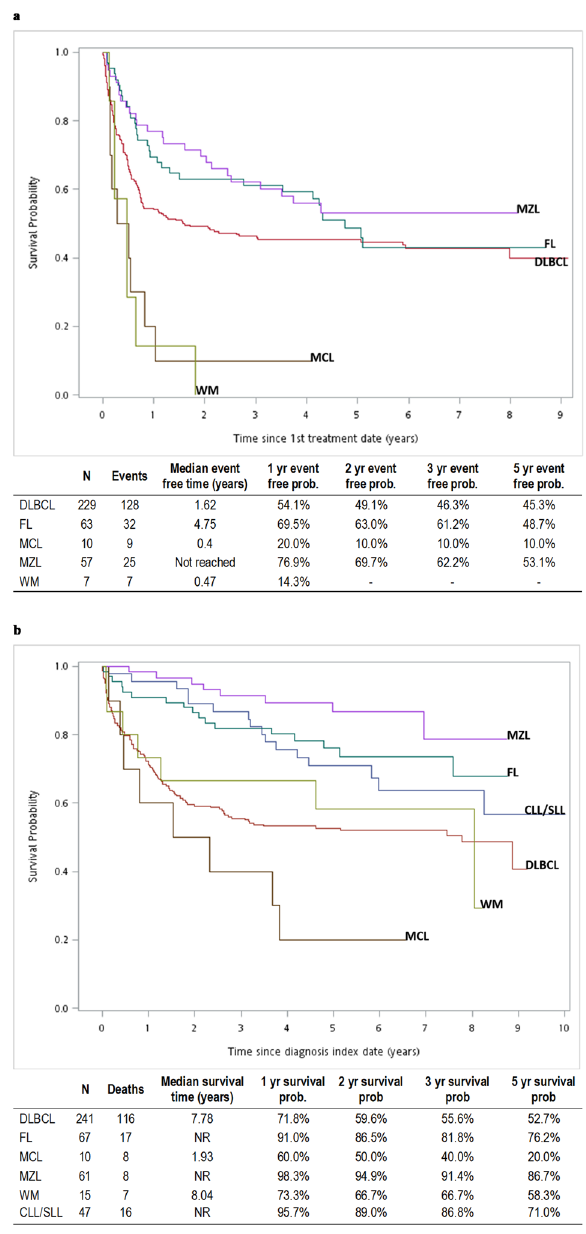
SLL, small lymphocytic lymphoma and chronic lymphocytic; DLBCL, diffuse large B-cell lymphoma; FL, follicular lymphoma; MCL, mantle cell lymphoma; MZL, marginal zone lymphoma; WM,